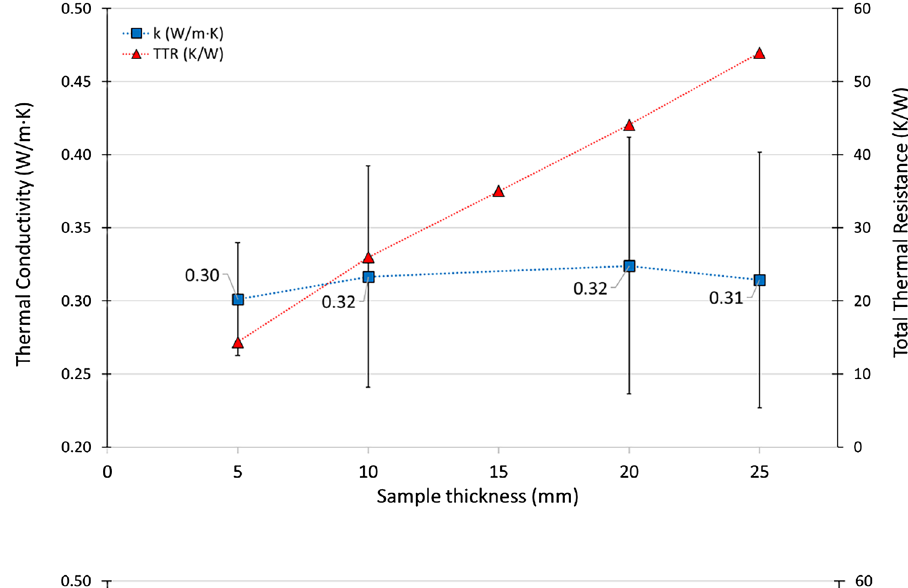
Fig. 7 Study result. Resin Type 2- WASHABLE [sample contact area 40 × 40 mm 2